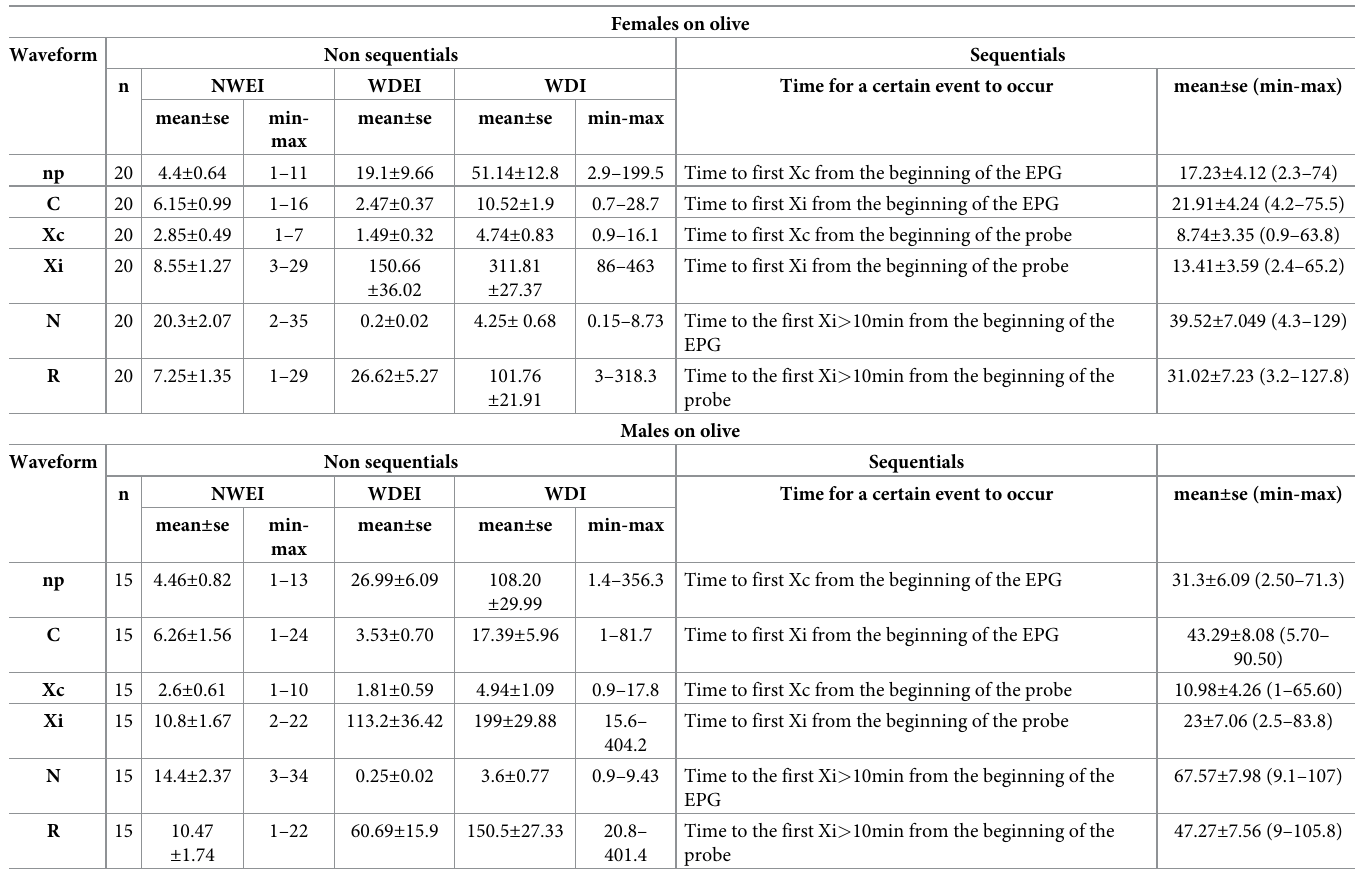
Table 2. Non-sequential and sequential EPG variables of adults of P . spumarius (males and females) on olive. Time is expressed in